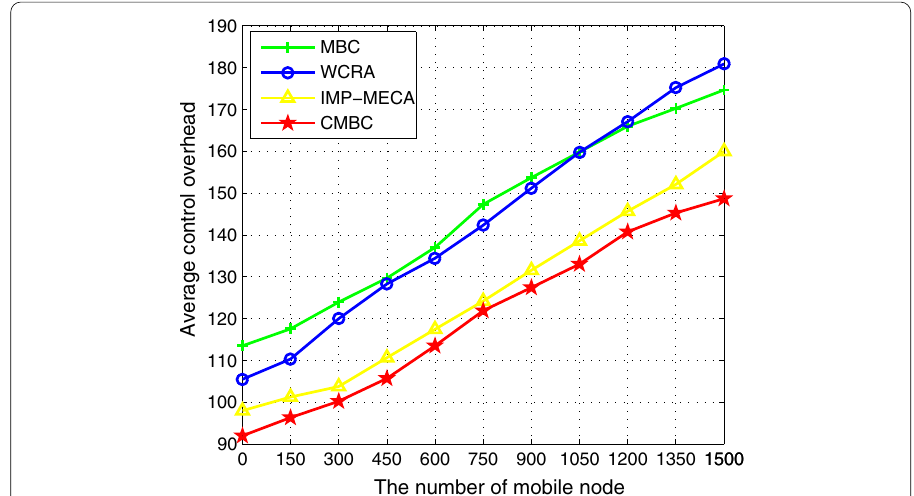
Fig. 7 Results comparison between the number of mobile node and the average control